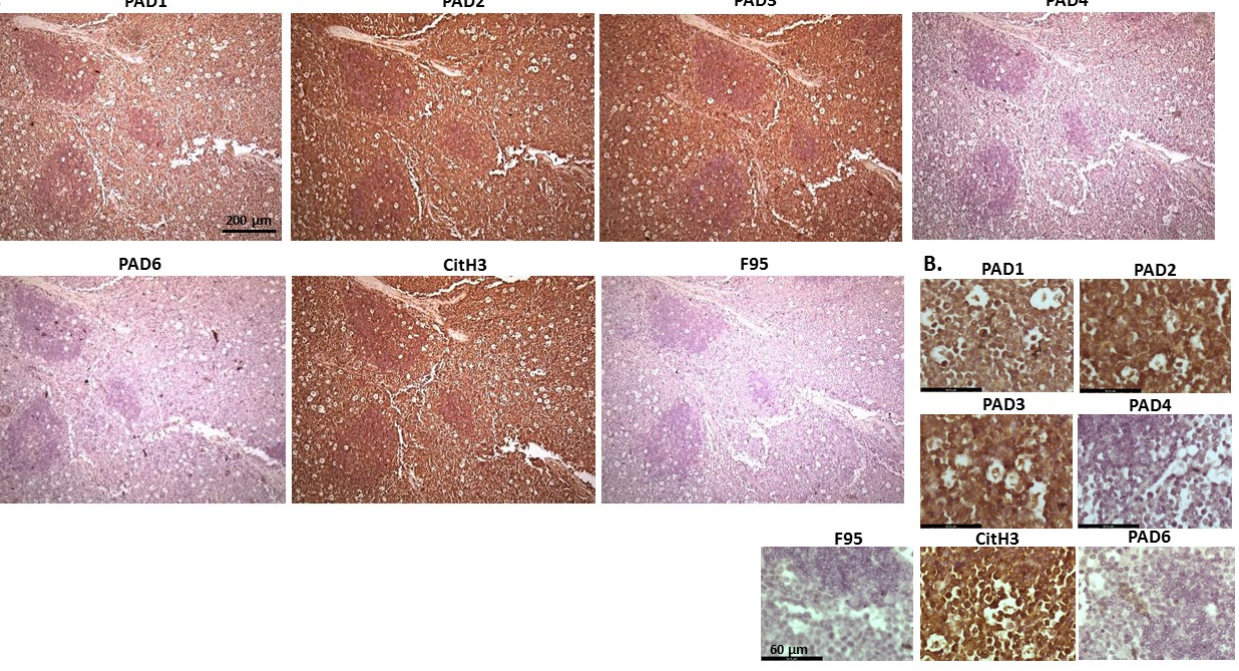
Figure 21. Cow—lymphoma. Organ samples from a cow kidney and lymph nodes were analysed. ( A ) Overview images for PAD1, 2, 3, 4, 6, CitH3, and F95 stainings of serial tissue sections; scale bar represents 200 μ m for all images; 10× objective. ( B ) Higher magnification shown for each staining from the images in ( A ); scale bar represents 60 μ m for all images; 40× objective.